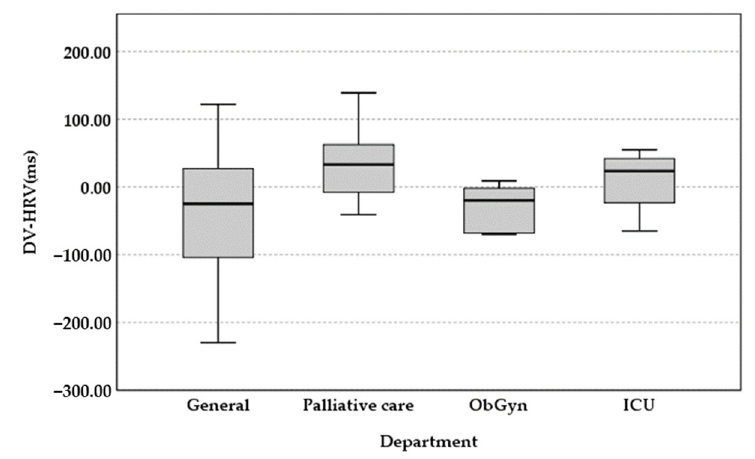
Figure 3. Pre-post difference value of HRV indicators.